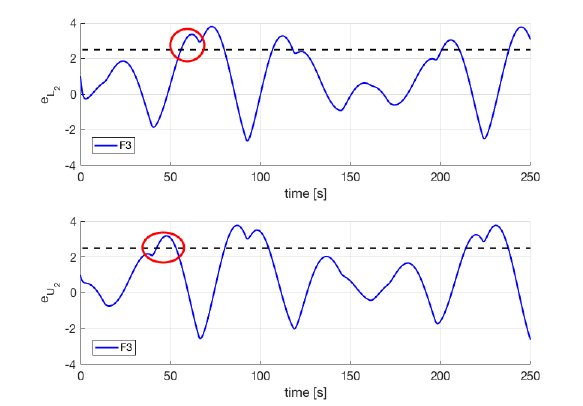
Figure 6. Fault F3 scenario. In this case, the residual signal e U